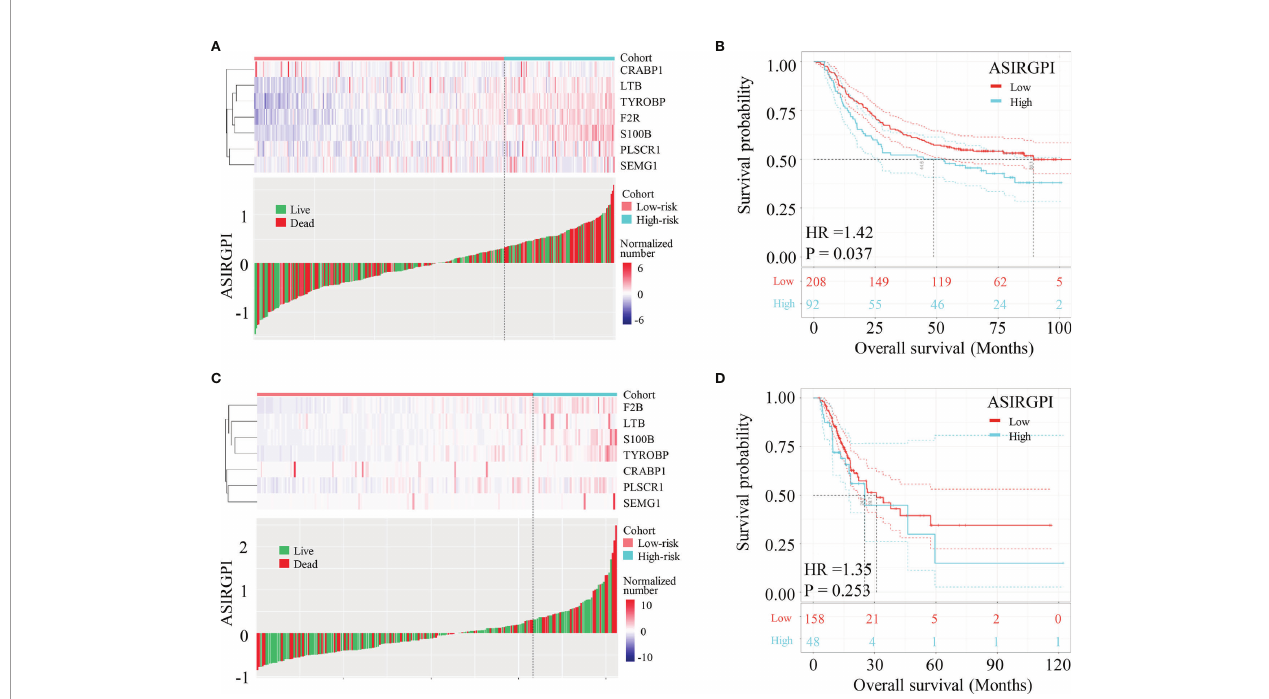
FIGURE 4 | Validation of ASIRGPI in the TCGA-STAD white cohort and ACRG cohorts. (A, B) The relationships between the expression of seven prognostic genes (upper) and risk score distribution with survival status (bottom) in the ACRG. Kaplan – Meier curves for the high (n = 92) and low (n = 208) risk score patient groups in the ACRG cohort. Log-rank test, p = 0.037. (C, D) The relationships between the expression of seven prognostic genes (upper) and risk score distribution with survival status (bottom) in the TCGA-STAD white cohorts. Kaplan – Meier curves for the high (n = 46) and low (n = 143) risk score patient groups in the TCGA-STAD white cohort. Log-rank test, p = 0.630.